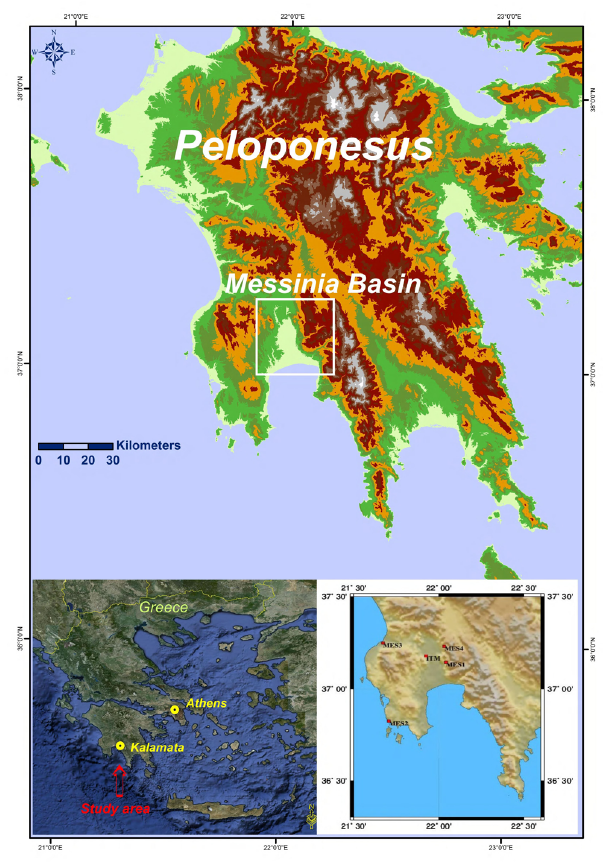
Fig. 1. Maps of Peloponnesus indicating the Messinia basin (up- per), the study area (lower left) and the NOA seismological stations (lower right). MES1, MES2, MES3 and MES4 indicate the portable seismological stations and ITM the permanent seismological station belonging to the